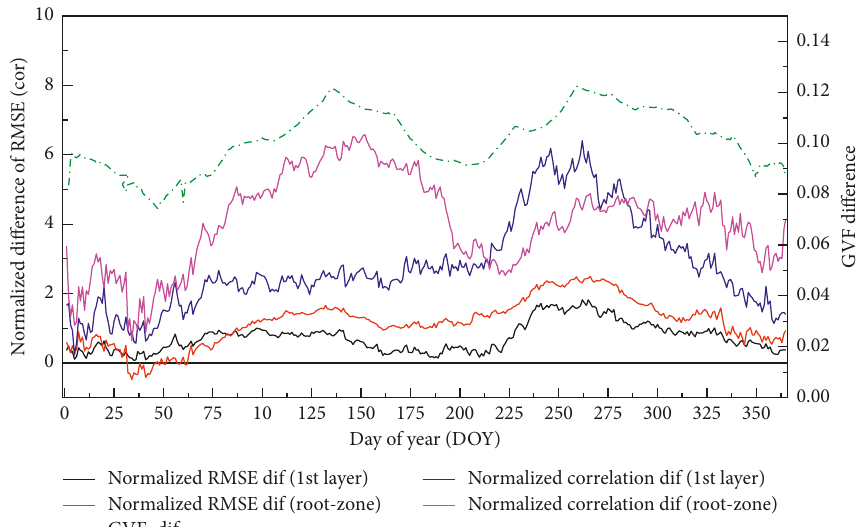
Figure 2: Normalized differences in RMSE and correlations between Noah estimates and in situ observations. Normalized RMSE dif- ference (RMSE (Noah-clim)–RMSE (Noah-NRT))/RMSE (Noah-clim); normalized correlation difference (cid:31) correlation (Noah-clim))/correlation (Noah-clim); surface and root zone SM are analyzed